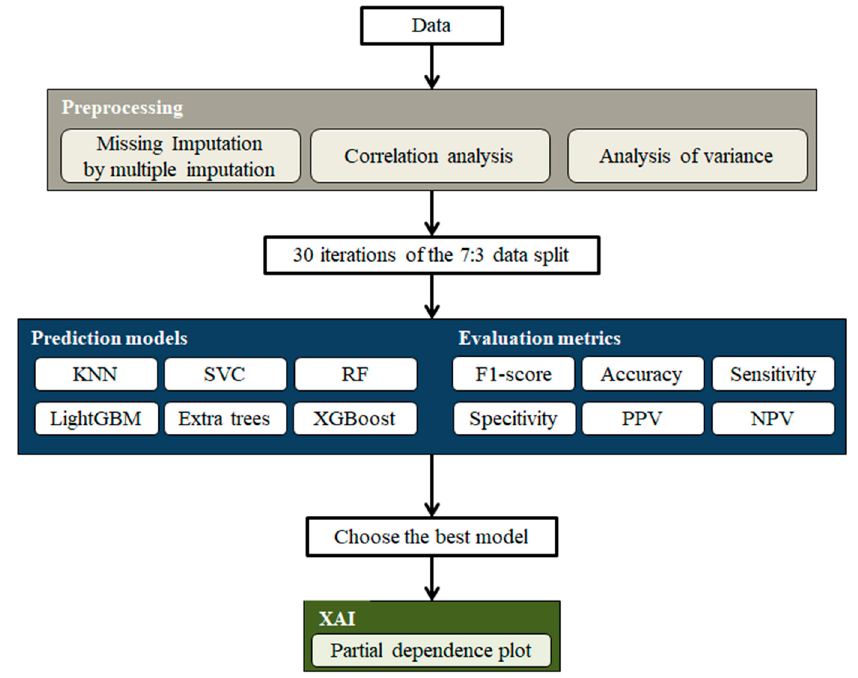
Figure 2. The overall workflow of the conducted study.